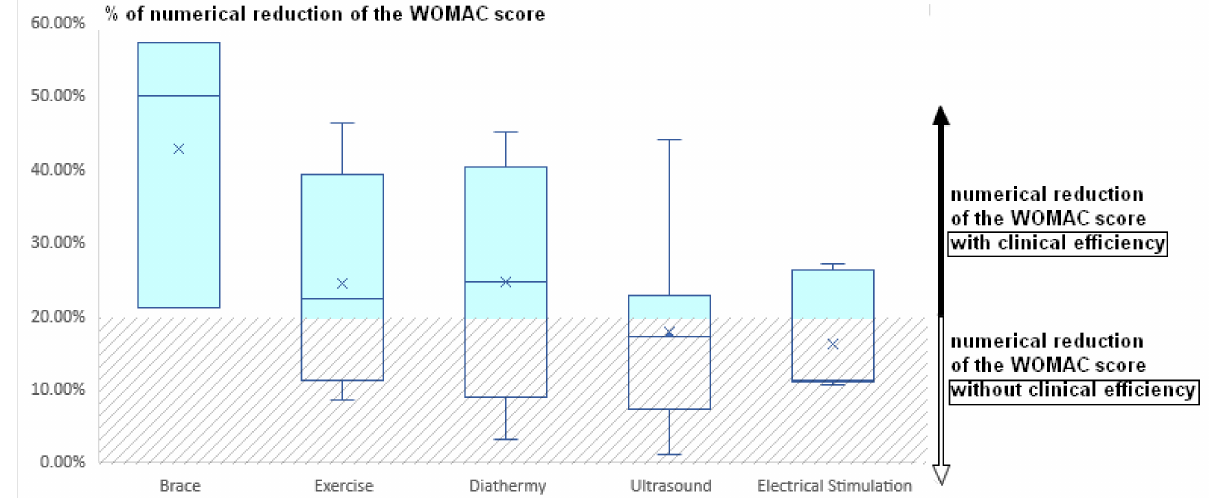
Figure 2. Mean percentage of numerical reduction of the WOMAC pain score from the papers with interventions regarding brace, exercise therapy, diathermy, ultrasounds, and electrical stimulation. Clinical efficiency is established when the percentage of numerical reduction is above a 20%